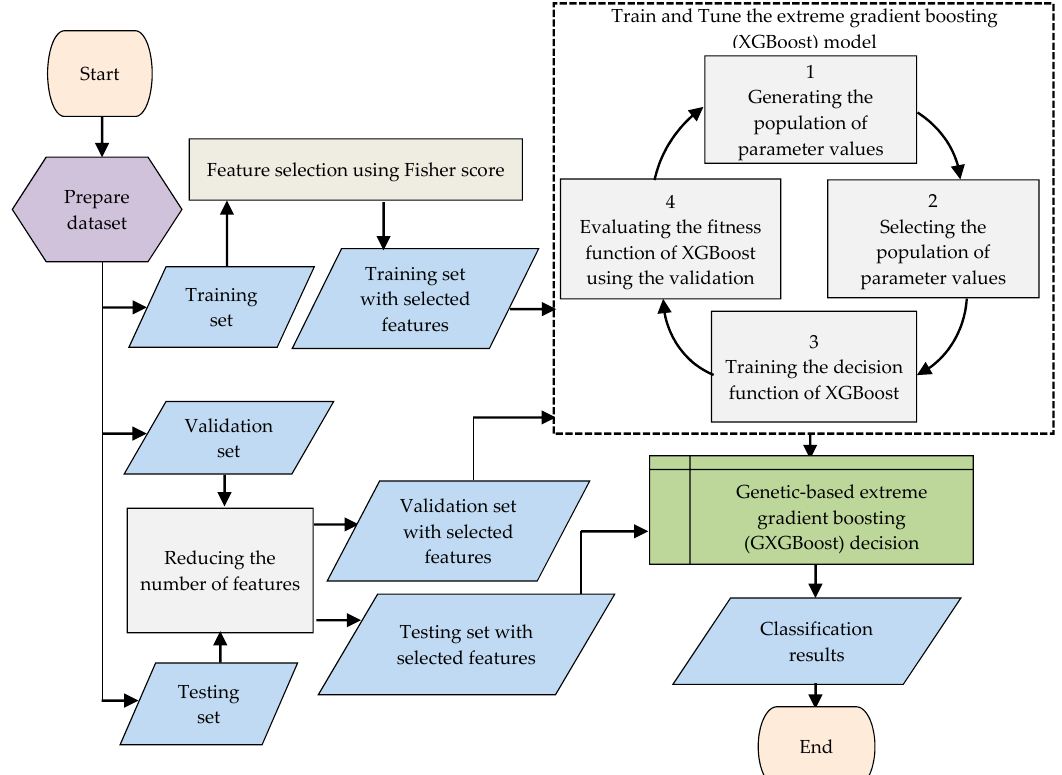
Figure 2. Flowchart of the proposed genetic-based extreme gradient boosting (GXGBoost) model and feature selection approach.